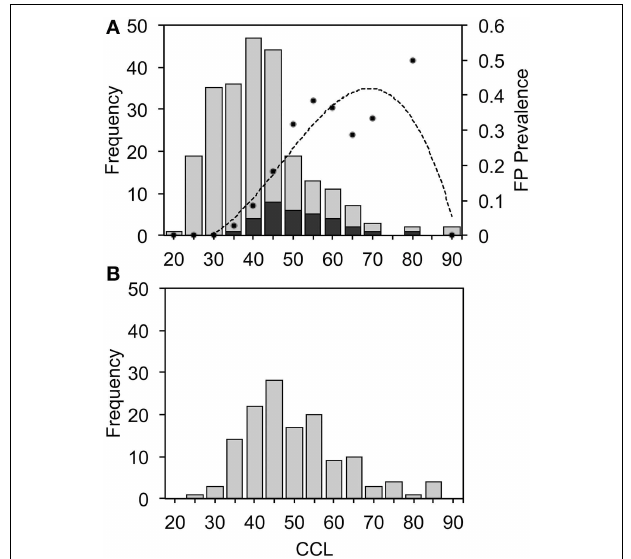
FIGURE 3 | Curved carapace length (CCL, cm) of green turtles captured during capture-mark-recapture surveys (A) or in the fishery (B), showing external signs of fibropapillomatosis (FP) (stacked black bars) or no FP (gray bars). Dots in (A) indicate FP prevalence within each size-class and the dashed line indicates a 3-order polynomial fit ( R 2 = 0 . 84 ) of FP prevalence by